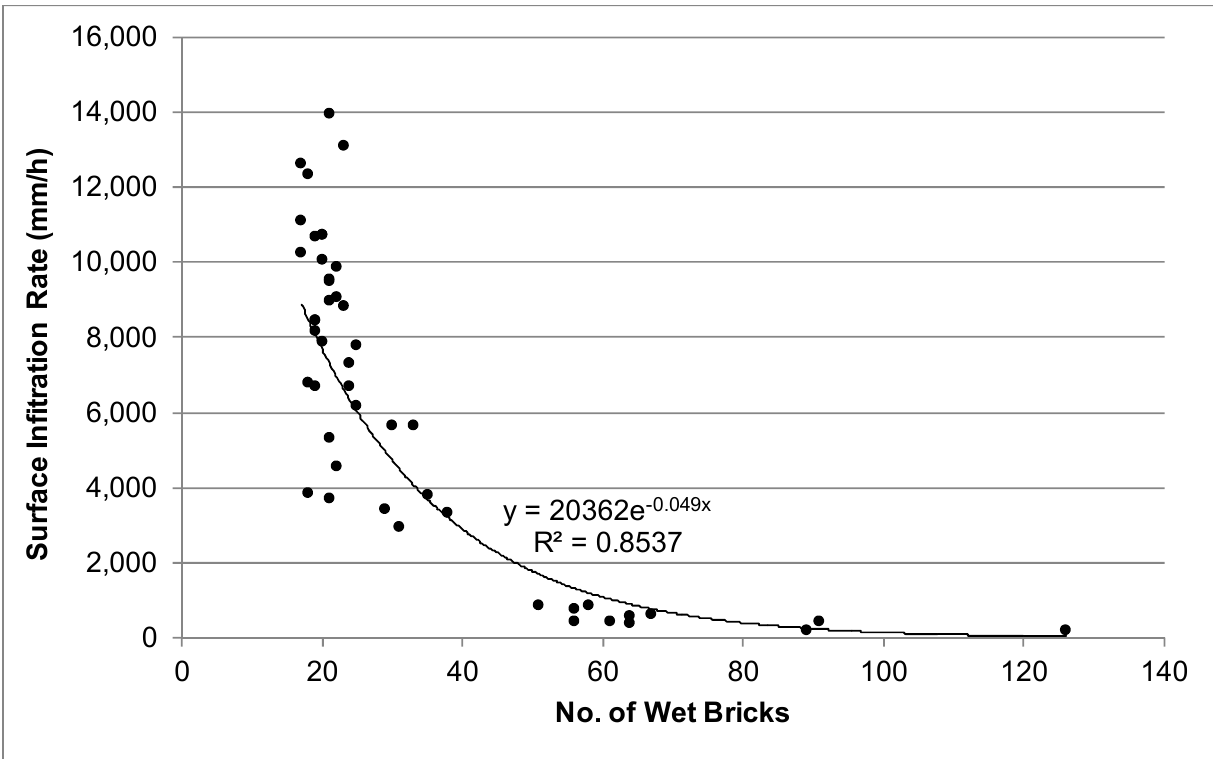
Figure 7. Comparison of PICP infiltration rates using SRIT and SWIFT methods.